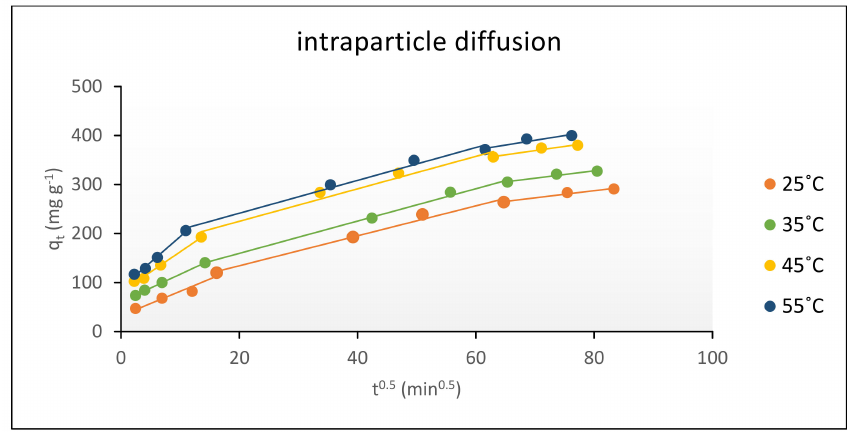
Figure 12. The intraparticle diffusion plots for adsorption of CR dye onto UCs at different temperatures.